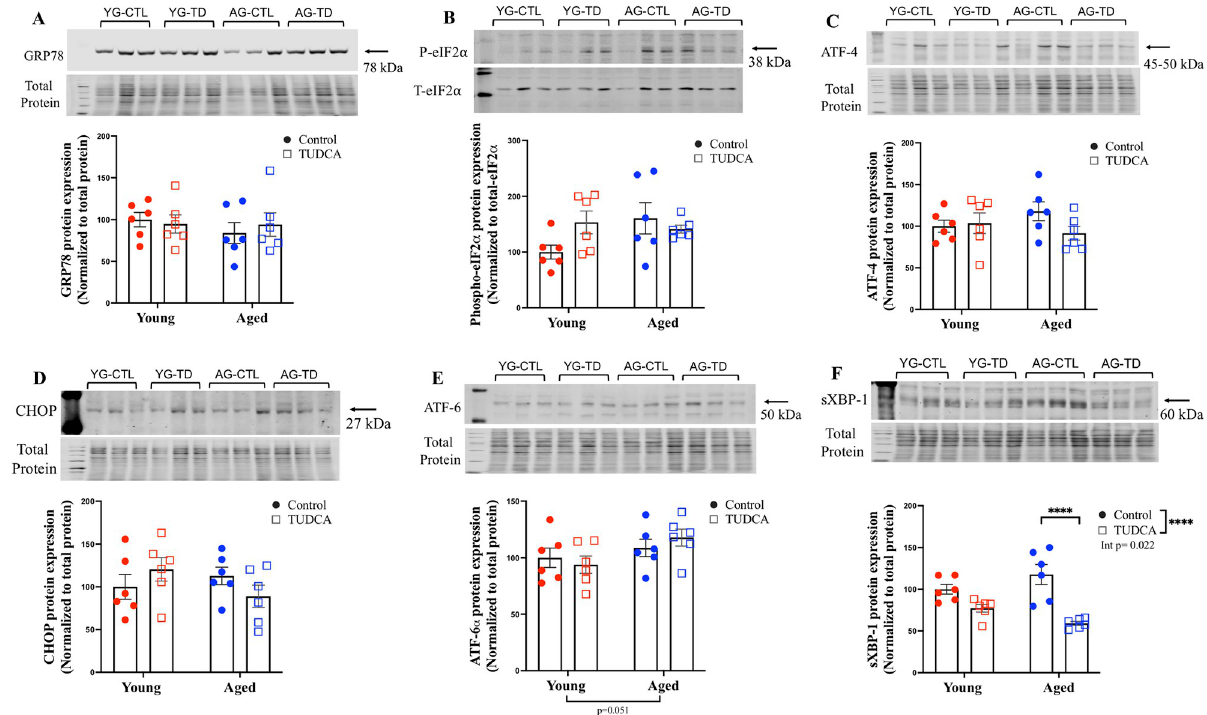
Fig 4. Male junctional zone. Western blot analysis of male junctional zone (A) GRP78, (B) phospho-eIF2 α , (C) ATF-4, (D) CHOP, (E) ATF-6 α , and (F) sXBP-1 normalized to total protein (except phospho-eIF2 α normalized to Total eIF2 α ) in male placenta junctional zone of young (3–4 months; in red) and aged control dams (9–9.5 months; in blue) with (open squares) or without (closed circles) TUDCA-treatment on gestational day 20. Data are presented as mean ± SEM and expressed as percentage of control (i.e., the mean of the young control dams); analyzed by two-way ANOVA with Sidak’s multiple comparisons post-hoc test; **** p < 0.0001; n = 6/group. YG-CTL = Young control dams; YG-TD = Young TUDCA-treated dams; AG-CTL = Aged control dams; AG-TD = Aged TUDCA-treated dams.